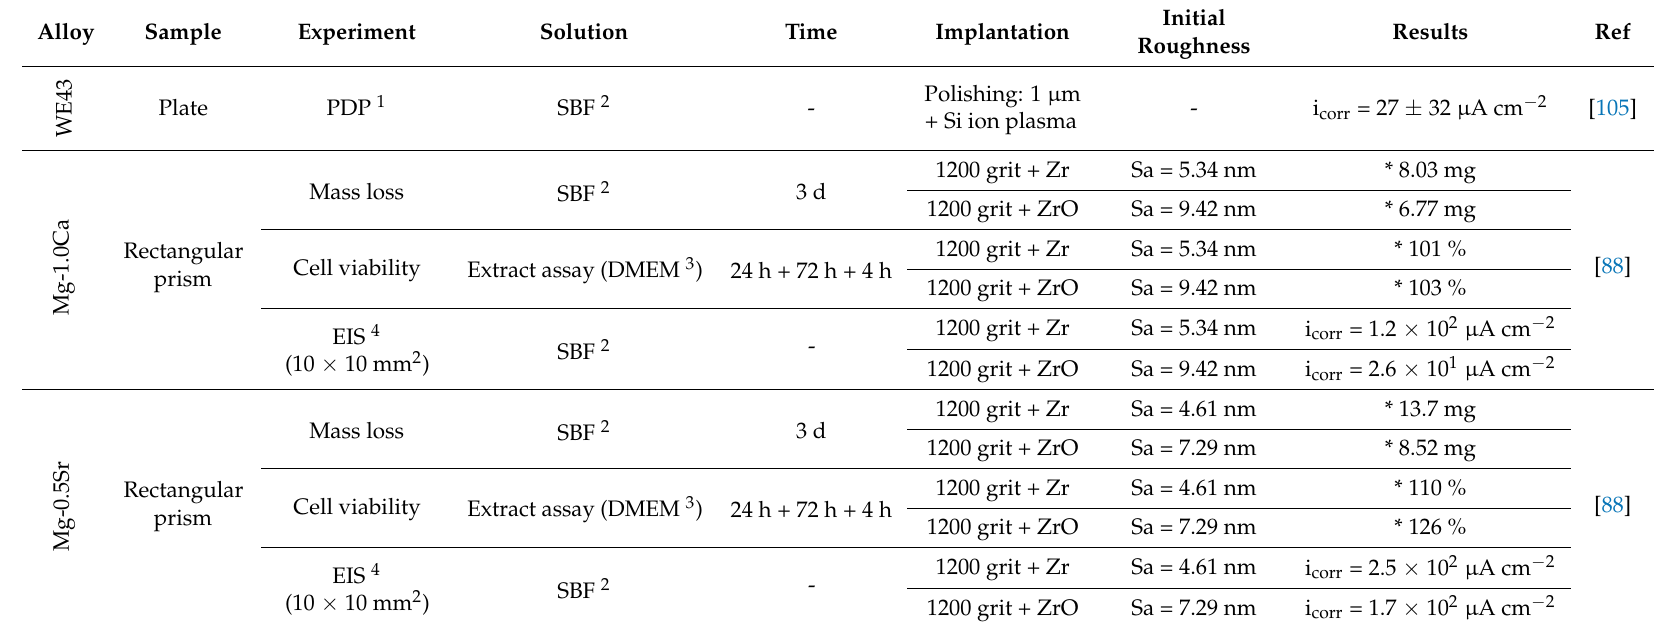
Table 5. Summary of different studies concerning the influence of ion implantation on the degradation behavior. * Values were determined from the diagram with the corresponding